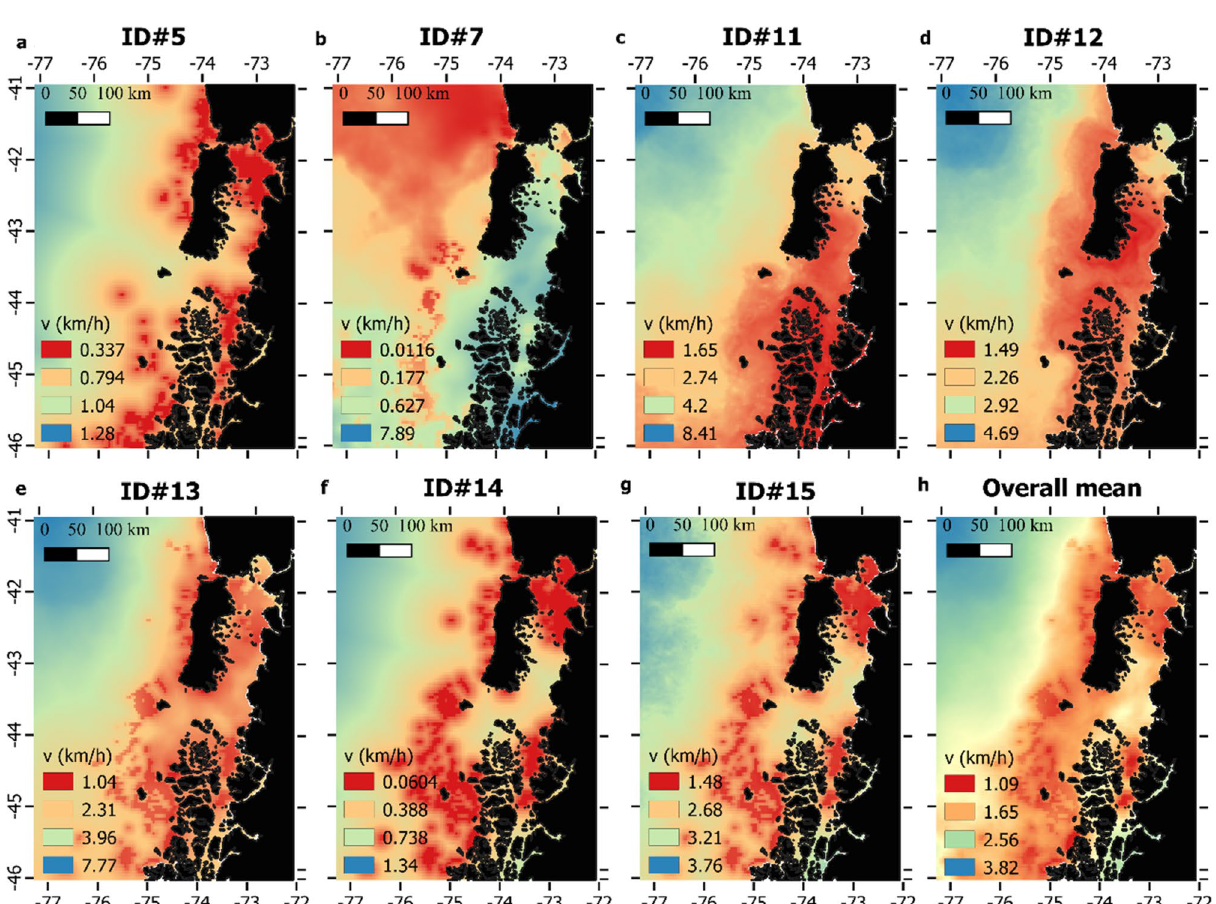
Figure 4. Spatial predictions of expected long-term velocity ( ν t ) responses in the entire study area, for every instrumented whale with more than 200 locations (panels a – g ). The bottom right panel (h) shows the overall mean for all seven individuals. Data layers (including maps) were created in R ver. 4.0.2 (www.r-proje ct.org) and ensembled in QGIS ver. 3.8.0 (www.qgis.org) for final rendering. Maps were created using data on bedrock topography from the National Centers for Environmental Information (https ://maps.ngdc.noaa.gov/viewe rs/ grid-extra ct/index .html). Values above 0 were considered land